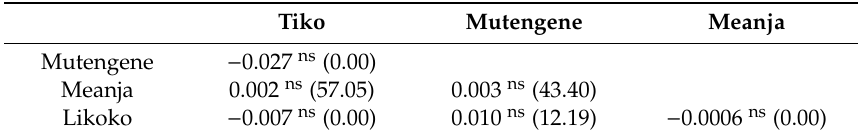
Table 3. Patterns of genetic di ff erentiation between An. funestus s.s. populations based on K ST estimates from GSTe2 mutation with